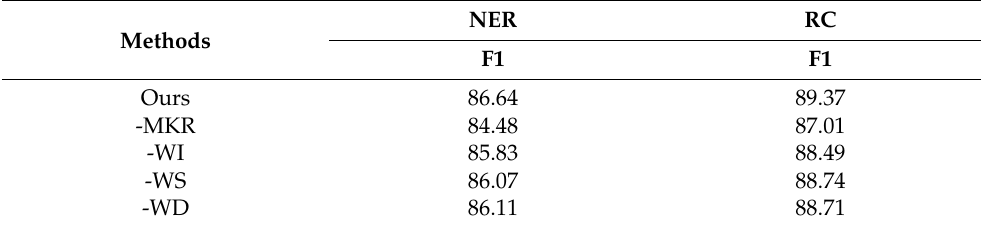
Table 7. The results of the ablation